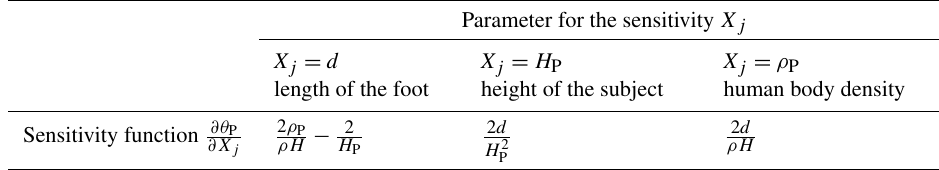
Table 1. Sensitivity of the general θ P (Eq. 12) with respect to geometry and density